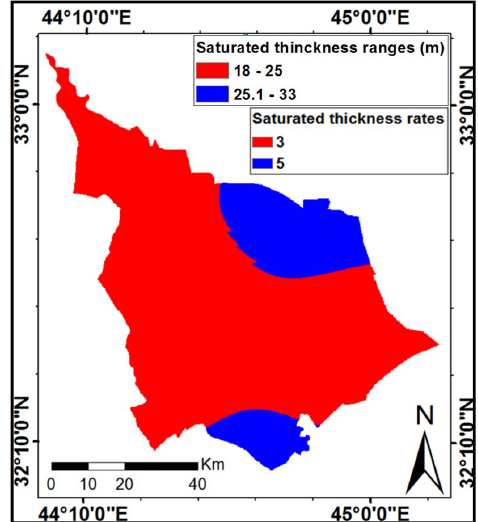
Figure 8. Saturated thickness maps (ranges and rates).